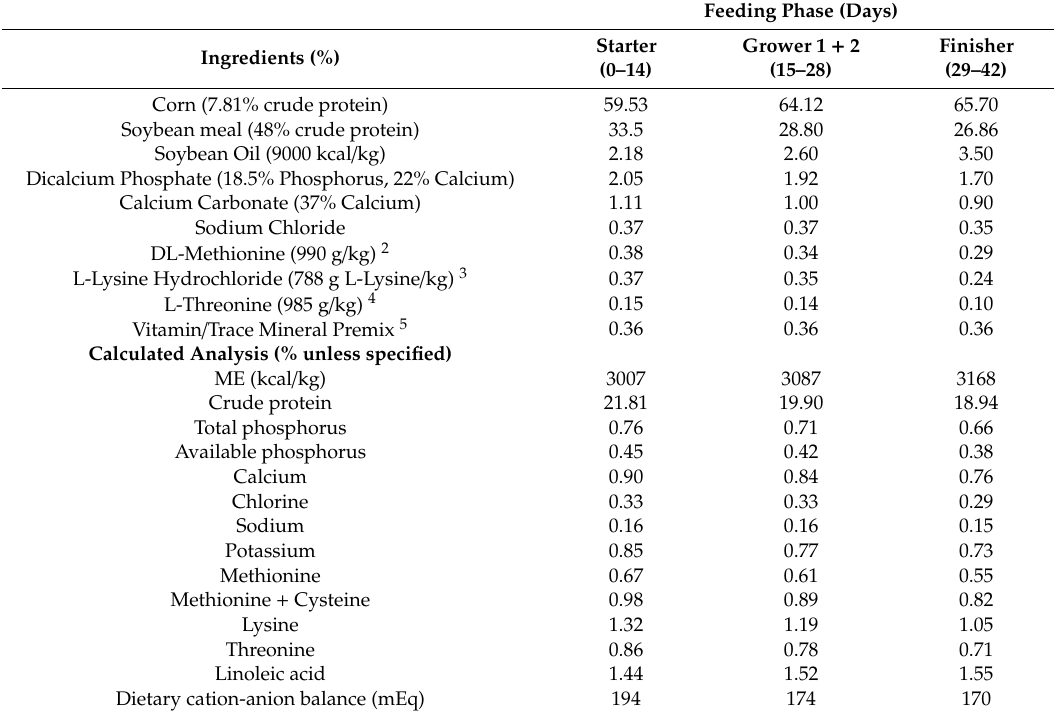
Table 1. Composition of basal diets (as fed basis, %) 1